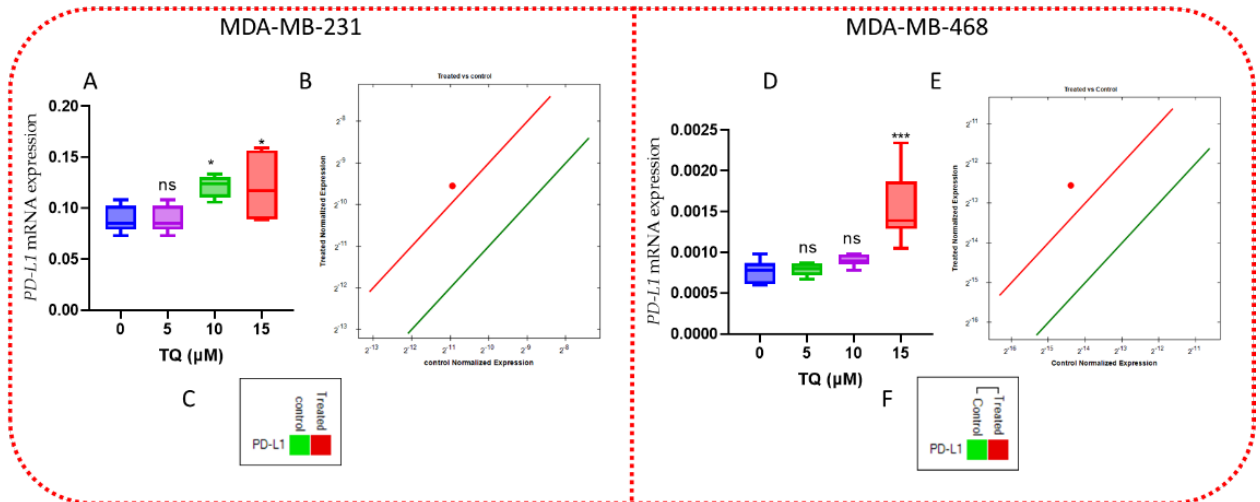
Figure 10. TQ’s effects on PD − L 1 mRNA expression. ( A , D ) The box and violin graph depicted the relative PD − L 1 mRNA expression after 15 µM TQ treatment versus control after 24 h incubation. The red dot represents PD − L 1 upregulation at 15 µM TQ ( B , E ). The green color represents PD − L 1 downregulation, while the red represents PD − L 1 upregulation 15 µ M TQ ( C , F ). The CFX96 software was used to analyze the expression. The error bars represent the mean and the standard error of the mean. A non-parametric student t − test was used to identify significant differences ( n = 3 per treatment in four independent experiments: * p < 0.05, *** p < 0.001, ns-nonsignificant comparing DMSO − and TQ-treated groups).